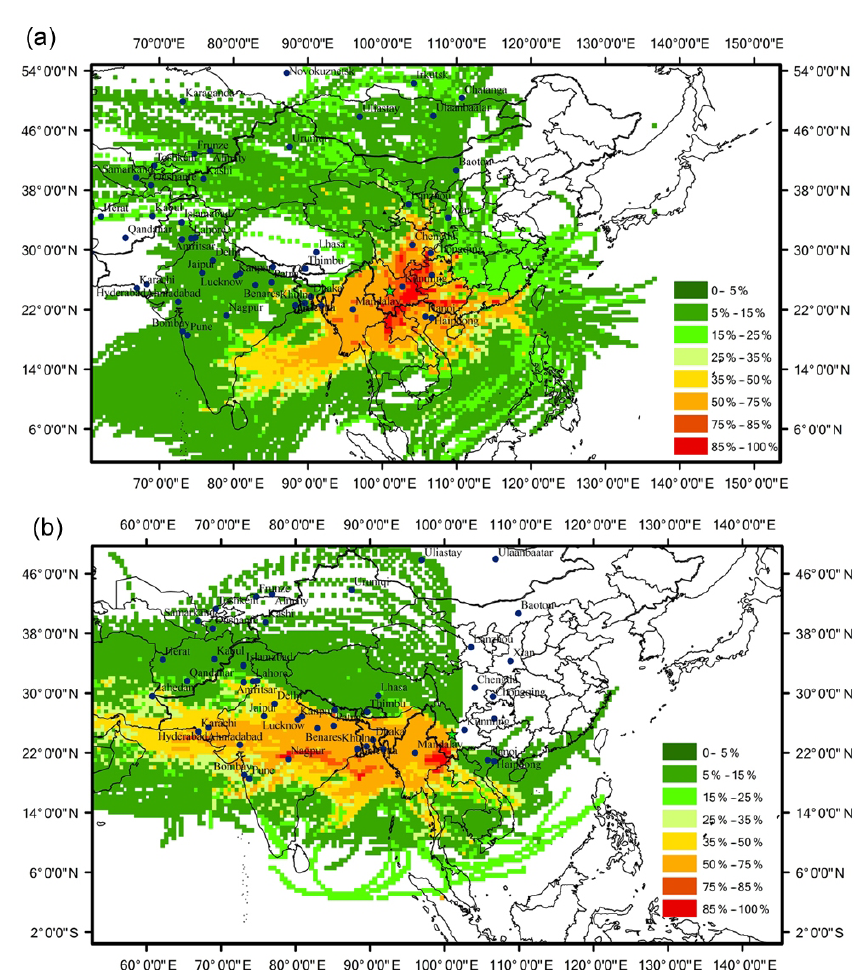
Figure 15. Potential source regions and pathways of atmospheric TGM at ALS as identified by the CWT during the ISM period ( a , May– September) and the non-ISM period ( b ,